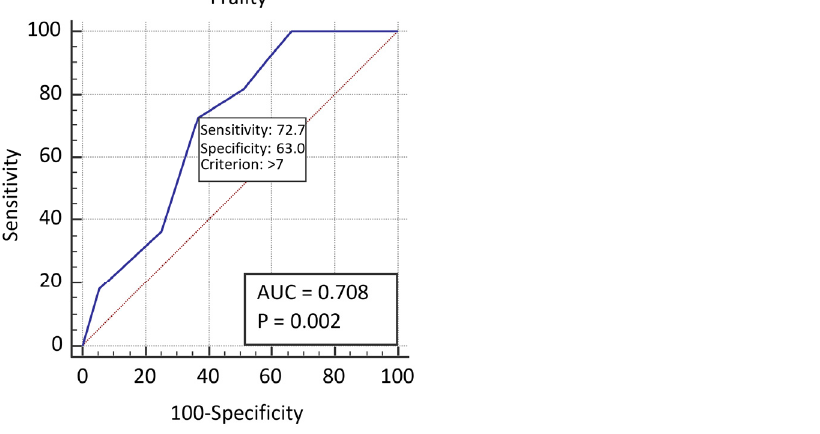
Figure 2. The ROC curves for the prediction of occurrence inappropriate shocks by frailty.